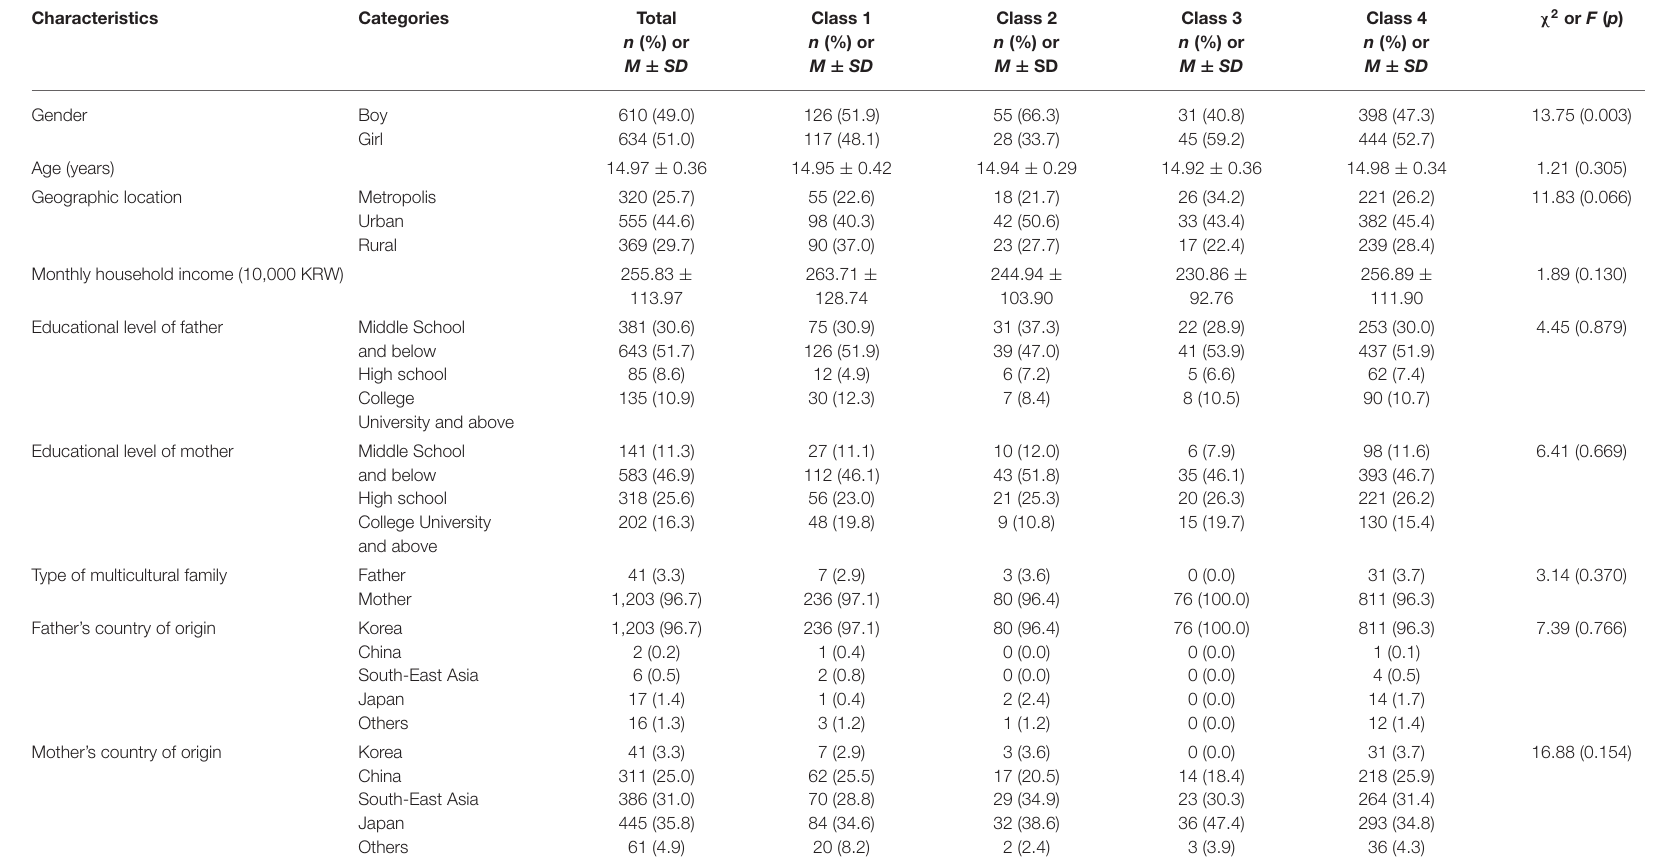
TABLE 3 | Differences in the characteristics of participants according to the profile group ( N =